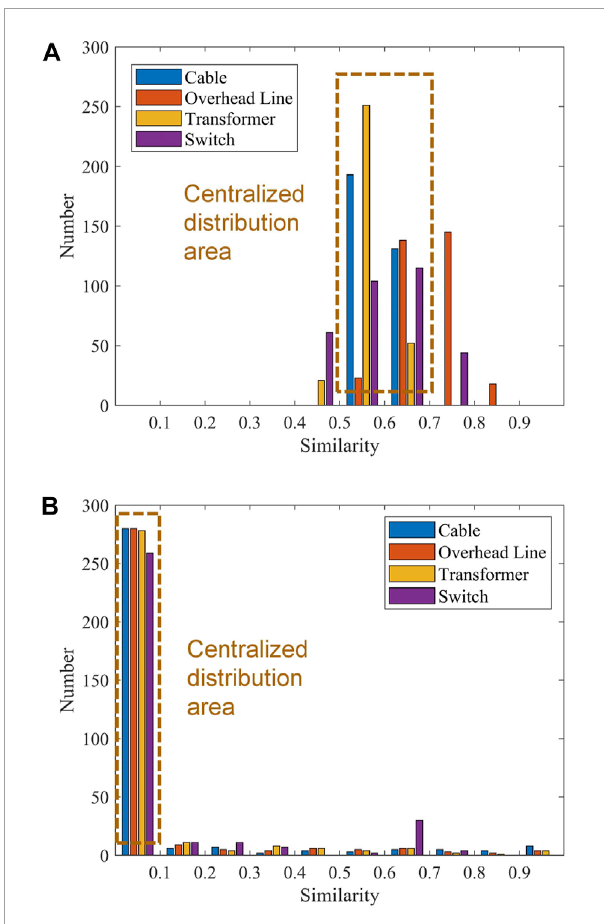
FIGURE 8 Performance of SCN in different electrical equipment. (A) Input image pair is the same, (B) input image pair is different.